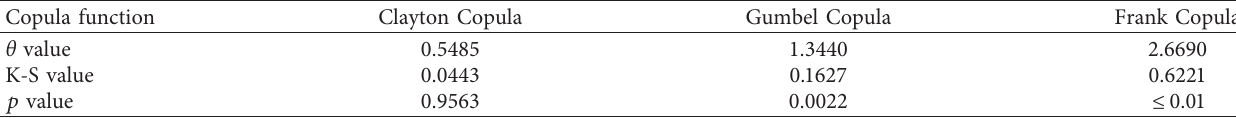
Table 2: Parameter estimates of Copula function and K-S test results.